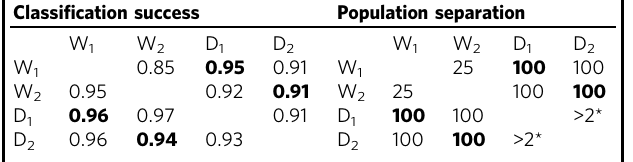
Table 1 Classi fi cation success of song recordings from four captive zebra fi nch populations based on a machine-learning algorithm (left) and approximate time of population separation in number of generations (right).